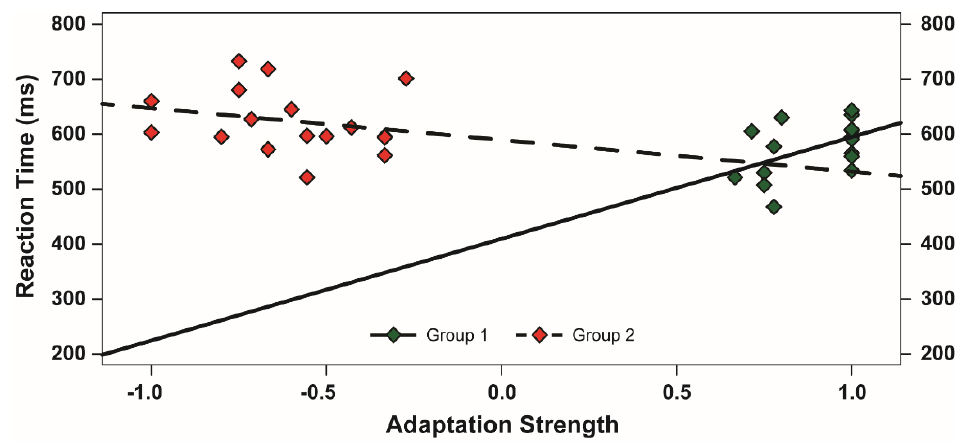
Figure 5. Relationship between the strength of McCollough effect induced in Phase 1 and performance in the categorization task, separately for participants in Group 1 (green diamonds and solid line) and Group 2 (red diamonds and dashed